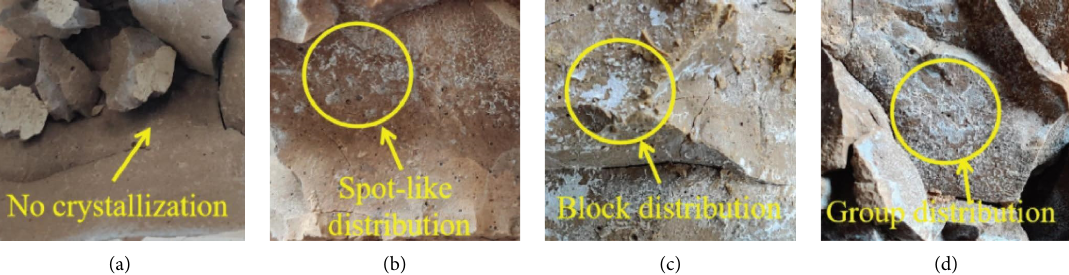
Figure 9: Internal characteristics of the glass fber-reinforced cemented soil after 5 freezing-thawing cycles in (a) water environment; (b) potassium acetate environment; (c) magnesium chloride environment; (d) sodium sulfate